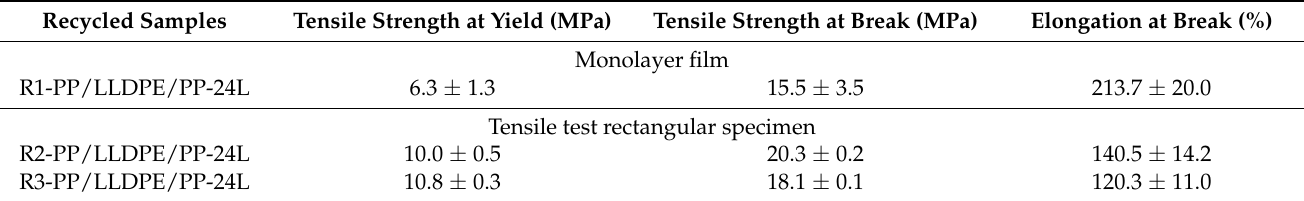
Table 4. Ensile strength properties in the machine direction of the recycled PP/LLDPE/PP-24L multilayer films following different recycling processes.